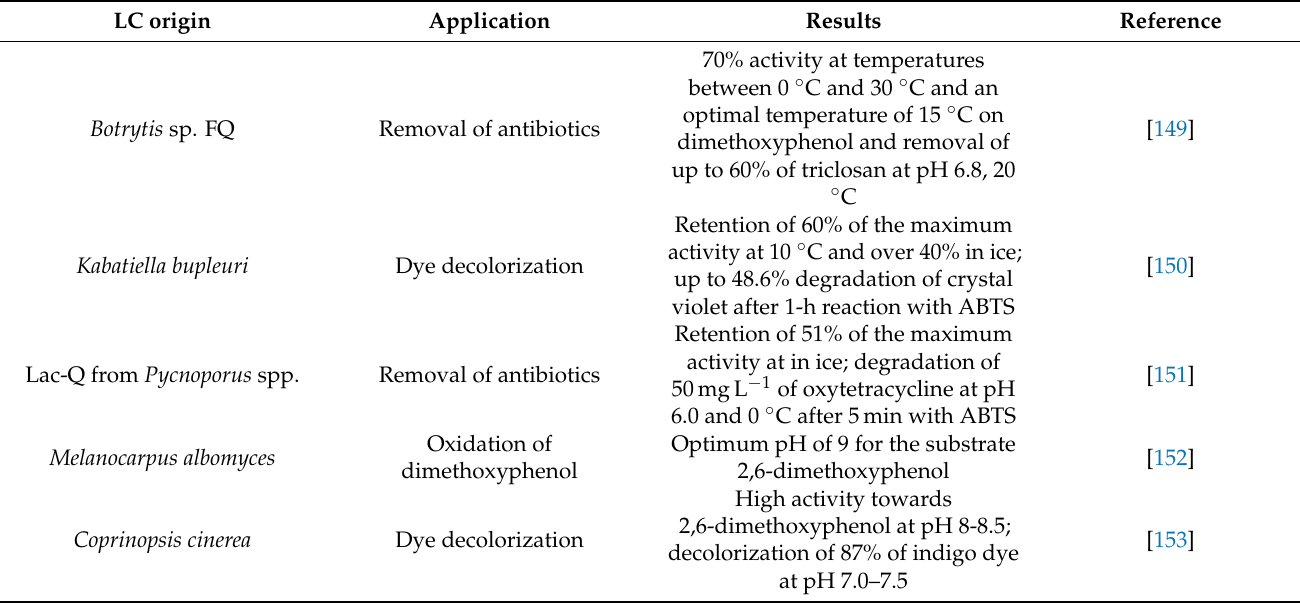
Table 4. Cold-active and alkaline active laccases and their